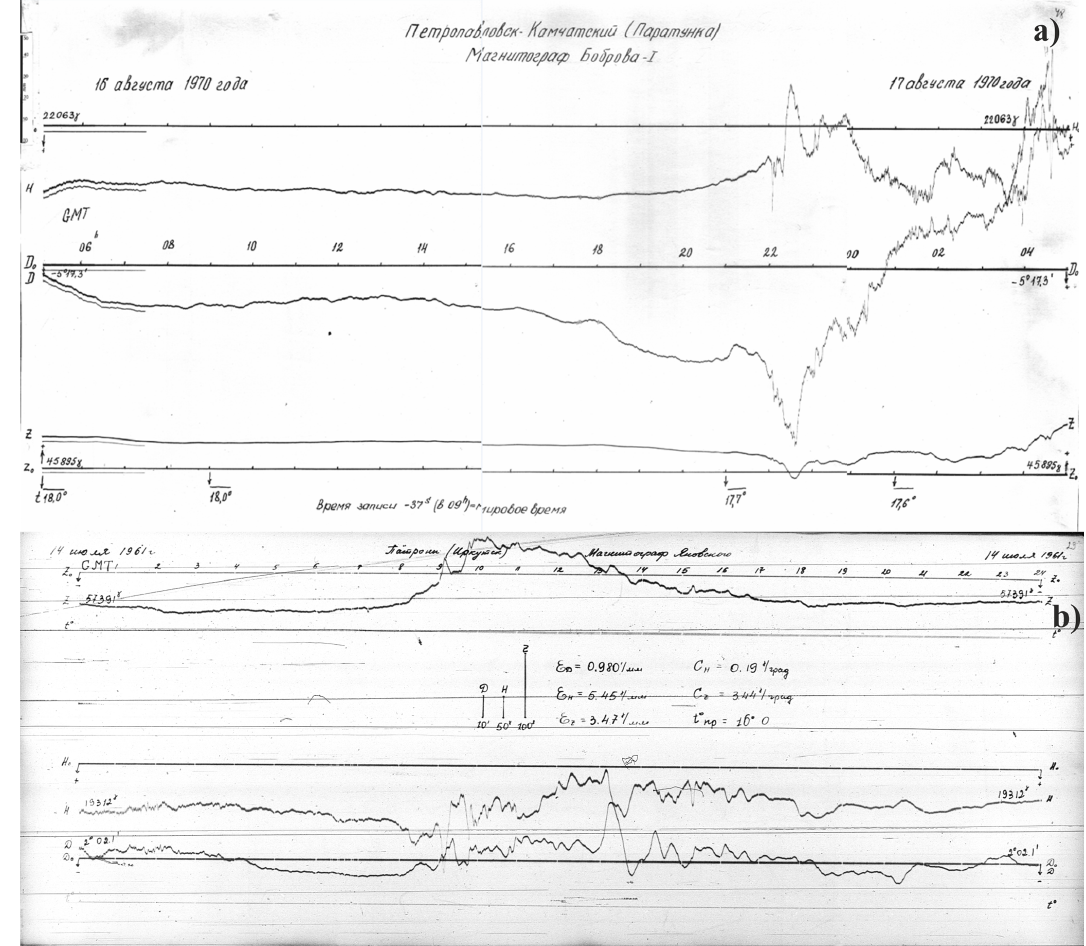
Figure 3. Photocopies of analogue magnetograms: (a) Petropavlovsk (Paratunka) observatory, 16–17 August 1970, Bobrov vari- ometer; (b) Irkutsk (Patrony), 14 July 1960, Yanovsky variometer (http://www.wdcb.ru/stp/geomag/magnetogr_list.en.html, last access: